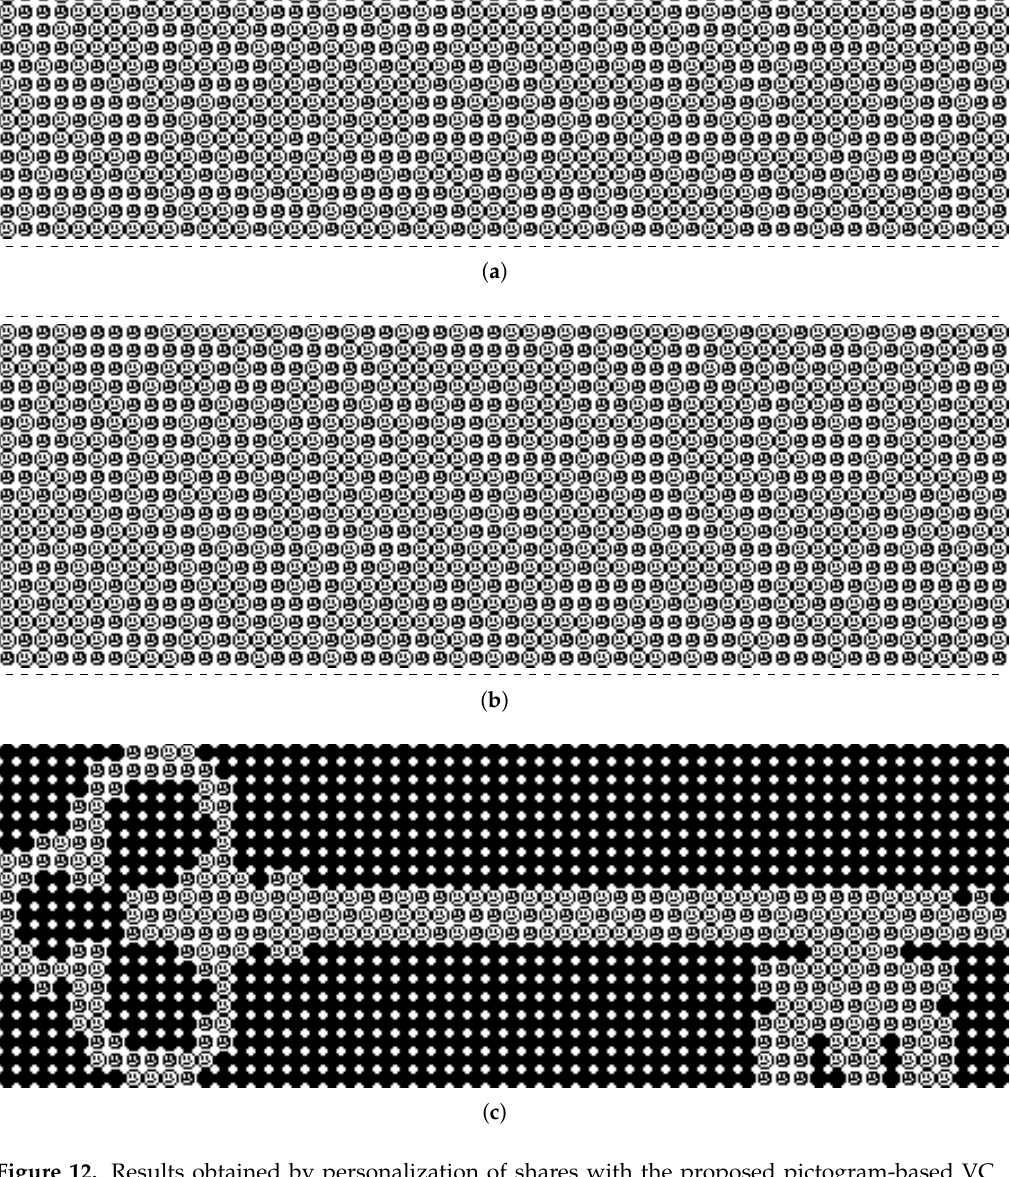
Figure 12. Results obtained by personalization of shares with the proposed pictogram-based VC technique. Emoticon-based positive and negative binary masks have been designed for share stylization from a picture image. The appearance of the generated shares is made aesthetic and used as a new medium of communication. ( a ) Generated Stylized Share 1 (encrypted image); ( b ) Generated Stylized Share 2 (encrypted image); ( c ) decoded picture by share